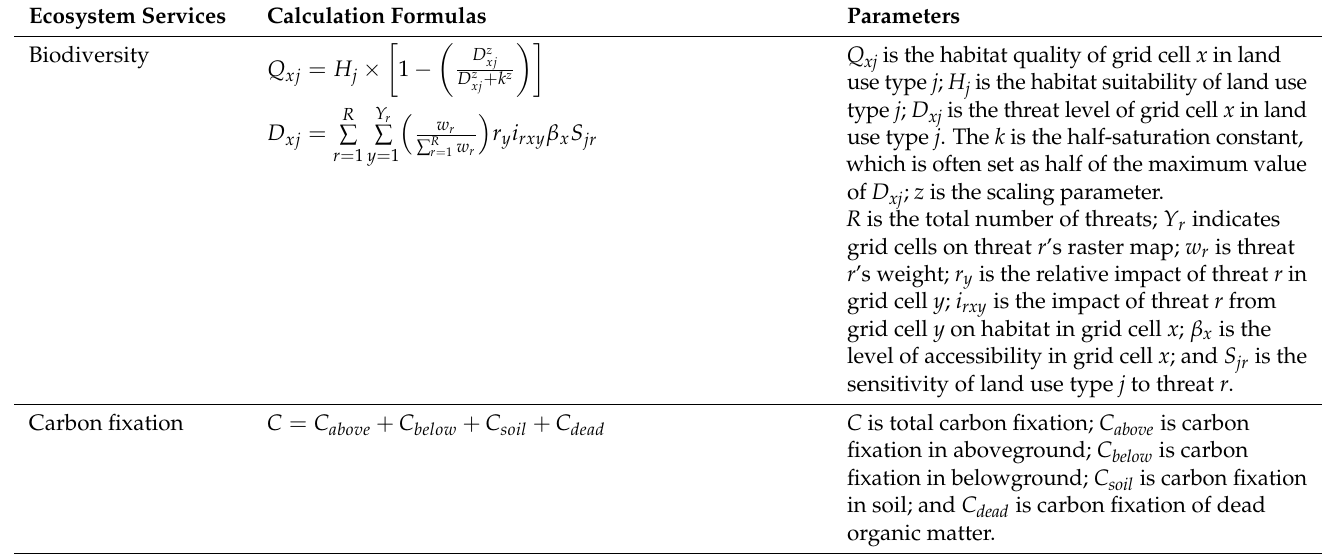
Table 2. Ecosystem service evaluation